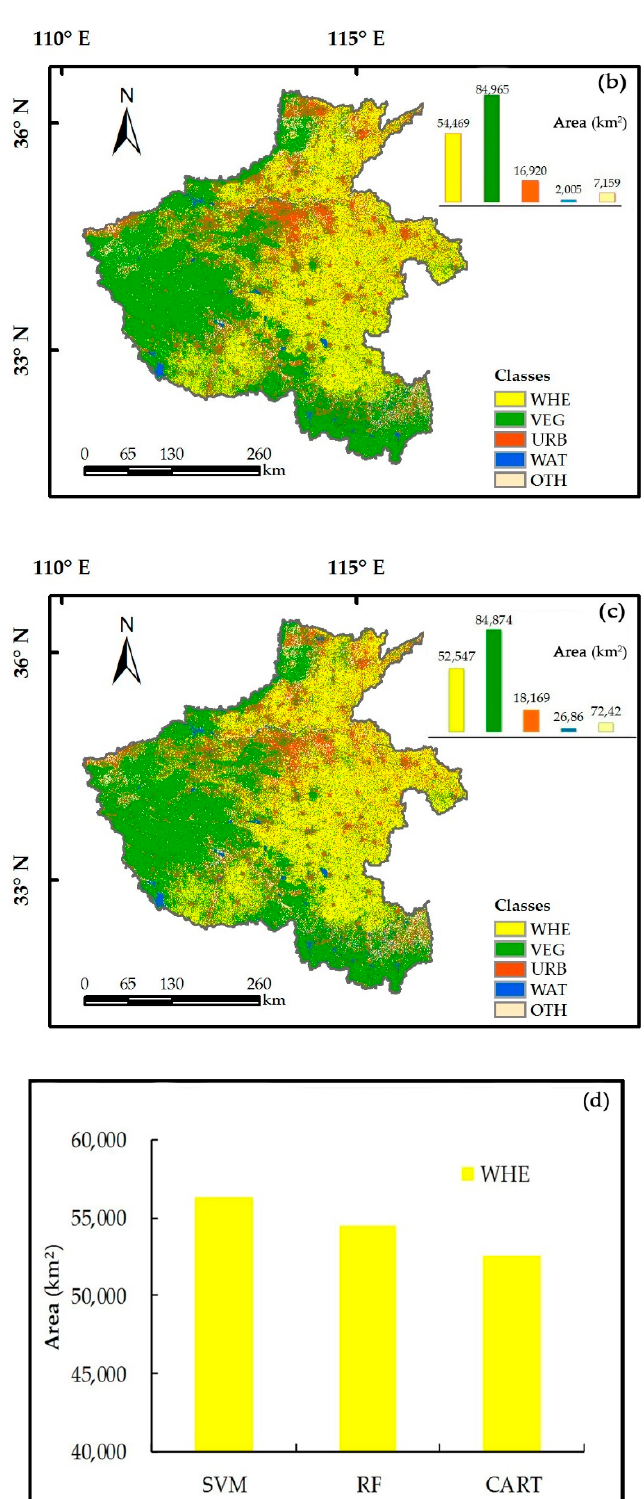
Figure 4. The classification results of the study area in 2019. ( a – c ) The classification results of support vector machine (SVM), random forest (RF), and classification and regression tree (CART), respectively. ( d ) Winter wheat areas of the three machine learning algorithms. WHE = Wheat, VEG = Vegetation, URB = Urban, WAT = Water, OTH = Other.